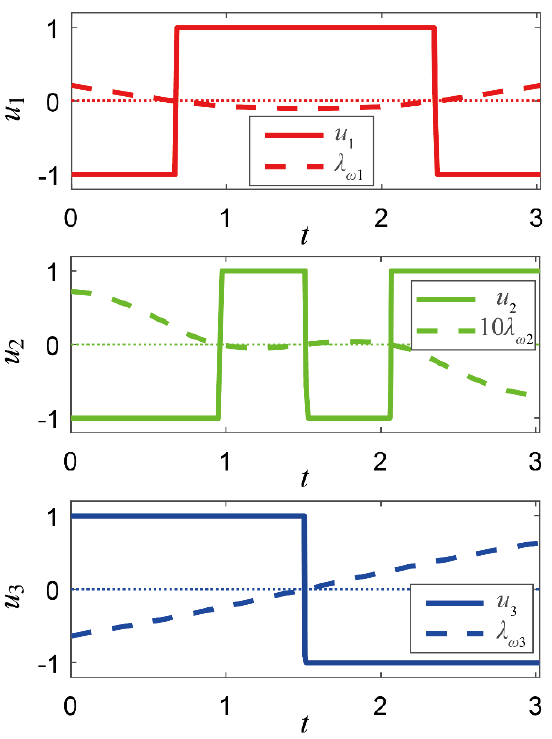
Figure 3. The optimal control histories and switching functions for Case 1.